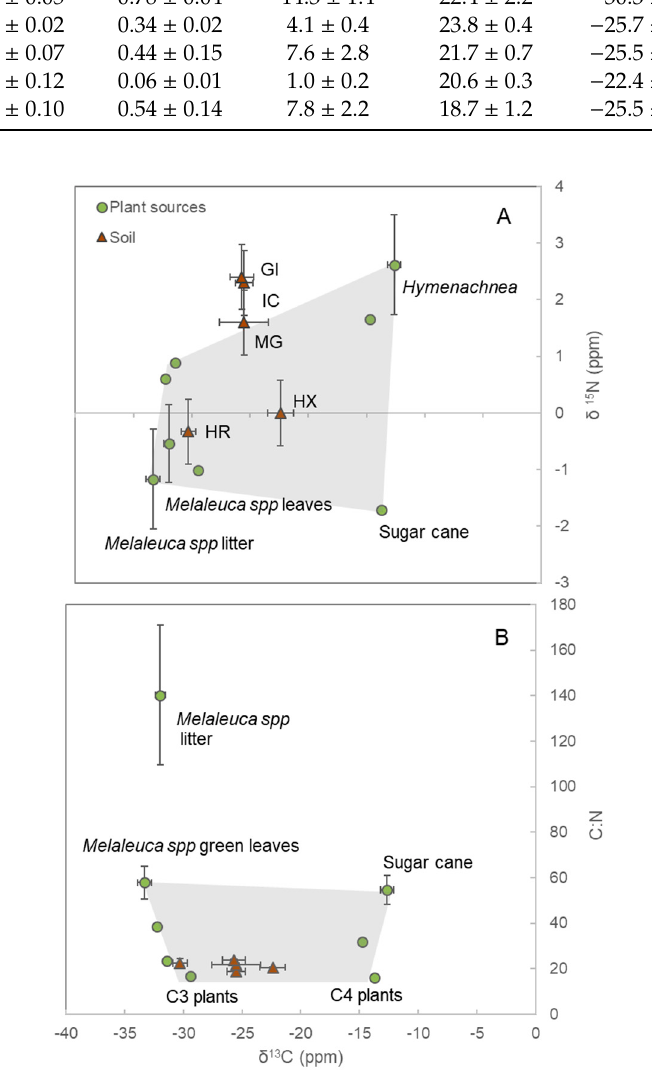
Figure 2. Surface (0–10 cm) soil (triangles) values for ( A ) δ 13 C versus δ 15 N; and ( B ) δ 13 C versus C:N of five forested floodplain wetlands, and potential end-members (circles) which included green and senescent leaves of Melaleuca trees, sugar cane, ferns, Hymenachne amplexicaulis , and other grass and shrubs picked from the sites. Values are shown as mean ± standard error of triplicate samples. The grey area comprises the isotopic “mixing polygon” (see Methods). The full names and location of the sampling sites can be found in Table 1 and Figure